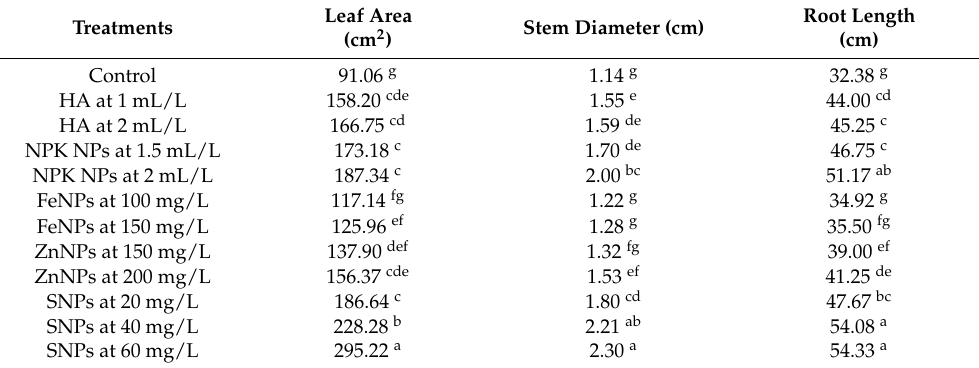
Table 3. Effect of nanoparticles and humic acid on leaf area, stem diameter, and root length in Philodendron bipinnatifidum during 2019/2020 and 2020/2021 seasons.